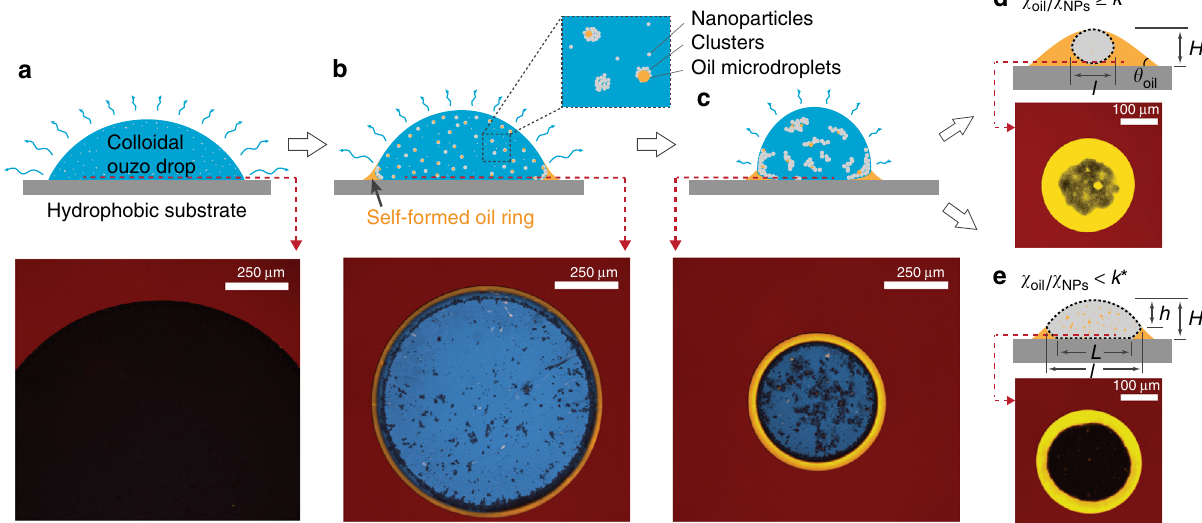
Fig. 2 Illustrations of ‘ self-lubrication ’ and the corresponding confocal photographs. Color indications under a confocal microscope: yellow, oil; blue, water/ ethanol; black, clusters of nanoparticles; red, substrate. a Initial state of evaporating drops of ouzo solution with well-dispersed nanoparticles. High nanoparticle concentration causes the black appearance of the drop under confocal. b Prevention of nanoparticle deposition at the contact line. Triggered by evaporation, the ouzo effect occurs, resulting in the formation of an oil ring (yellow), which prevents pinned contact lines and equips colloidal drops with high mobility and low hysteresis. Meanwhile, nanoparticles aggregate and oil microdroplets nucleate on them. c The shrinkage of the oil ring. The oil ring sweeps nanoparticles/clusters from the substrate. After the evaporation of ethanol and water, the generated supraparticles either fl oat on the residual oil, as illustrated in d , or sit on the substrate, as illustrated in e , depending on the volume relationship between the supraparticle and the remaining oil. All the confocal photographs are from a horizontal scanning just above the